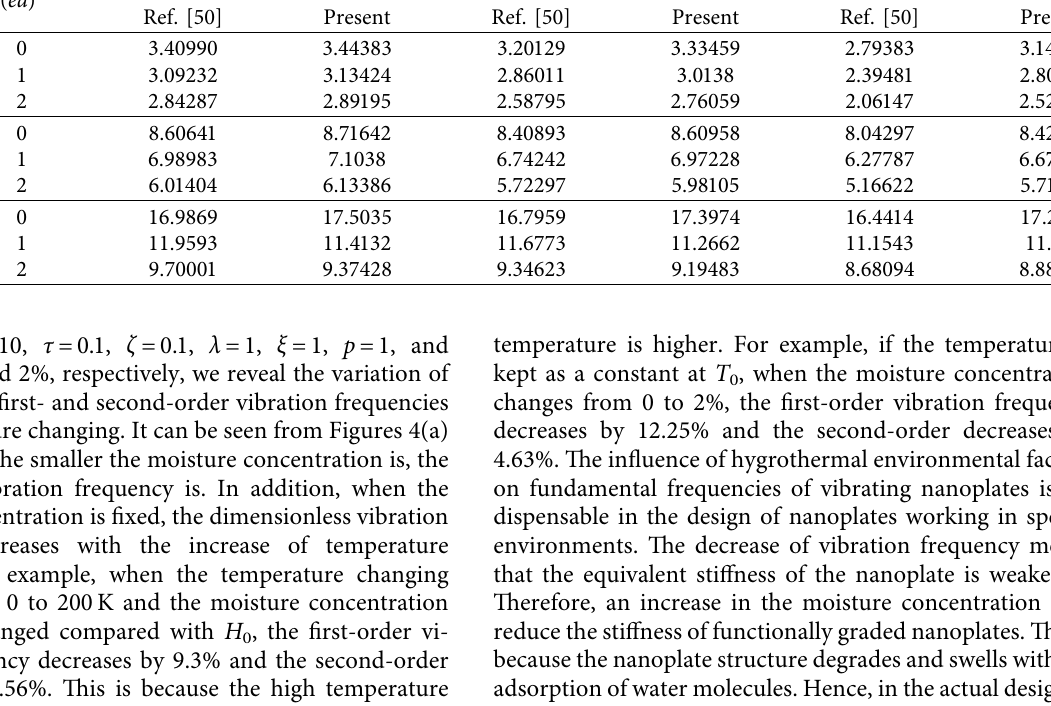
Table 2: Comparison of nondimensional fundamental natural frequencies of FG nanoplates subjected to uniform temperature rise. L a / L